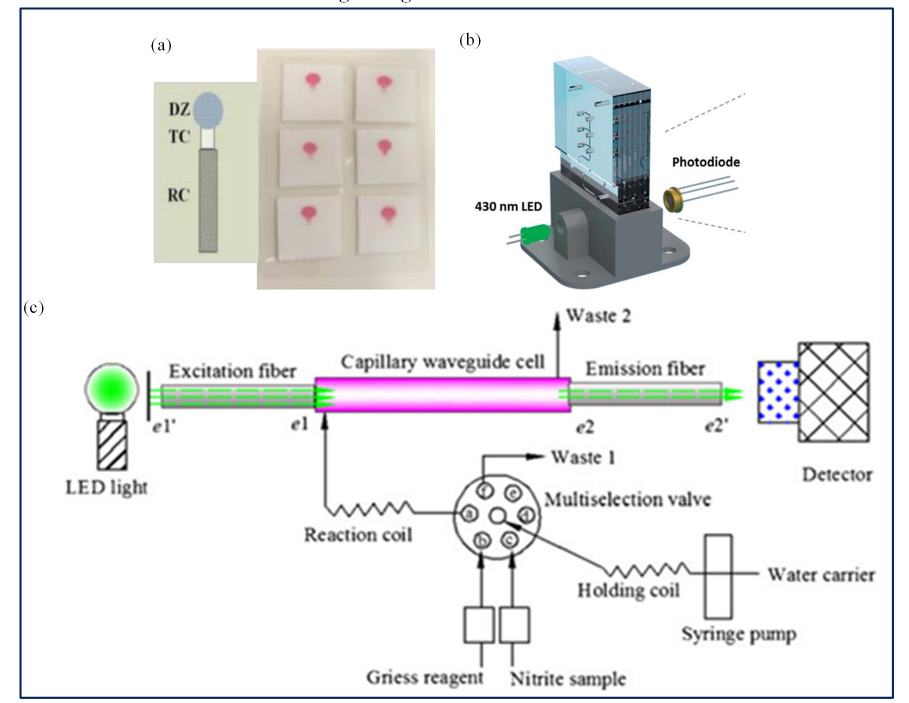
Figure 9. ( a ) Quantification of nitrite and nitrate using disposable µ PAD [152]; ( b ) schematic of the flow system and detection cell of LED-based nitrate sensors [149]; and ( c ) schematic of the fiber-optic chemical sensor (FOCS) method for nitrite measurement